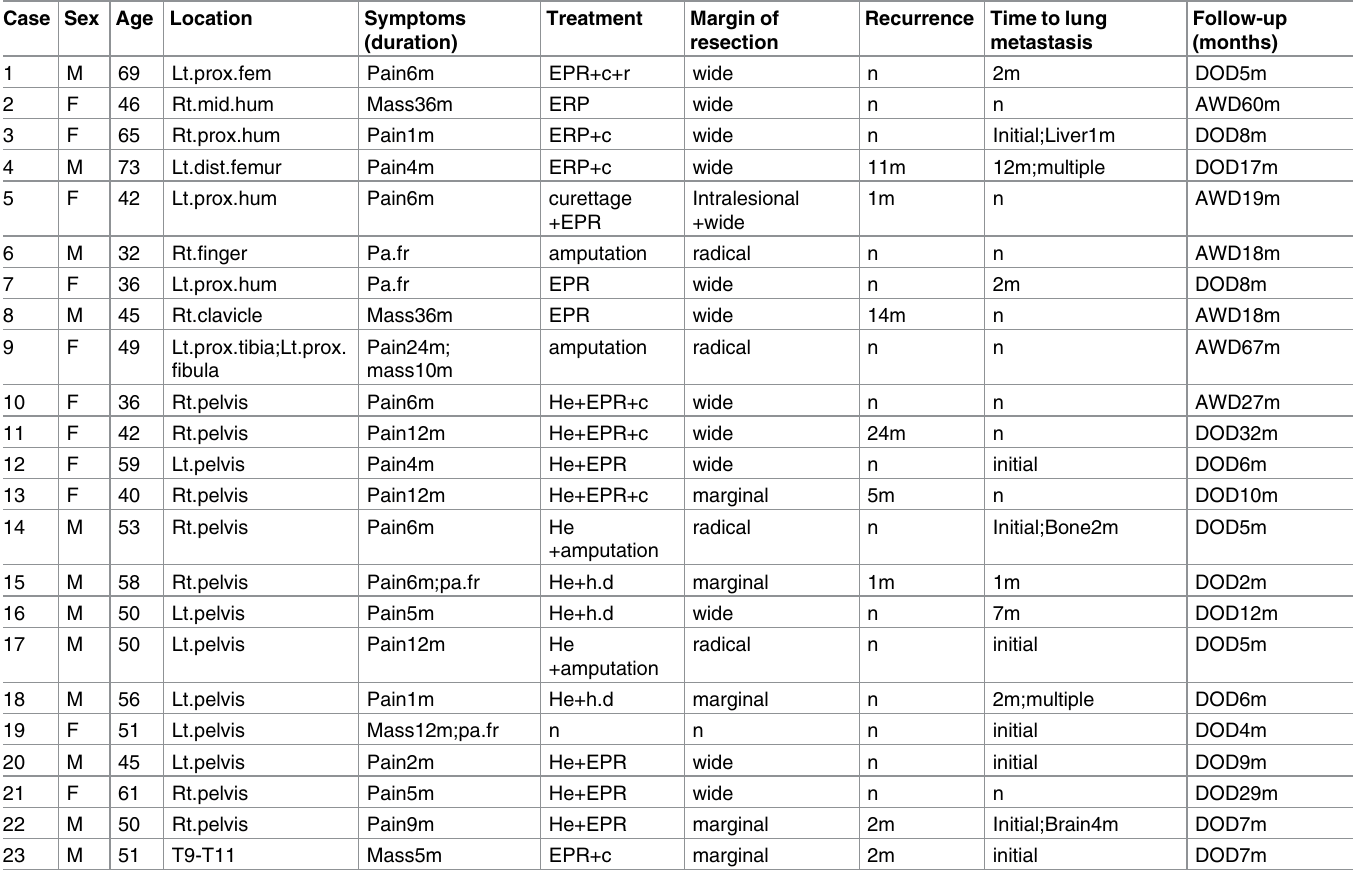
Table 1. Clinical information about caseswith dedifferentiated chondrosarcoma.